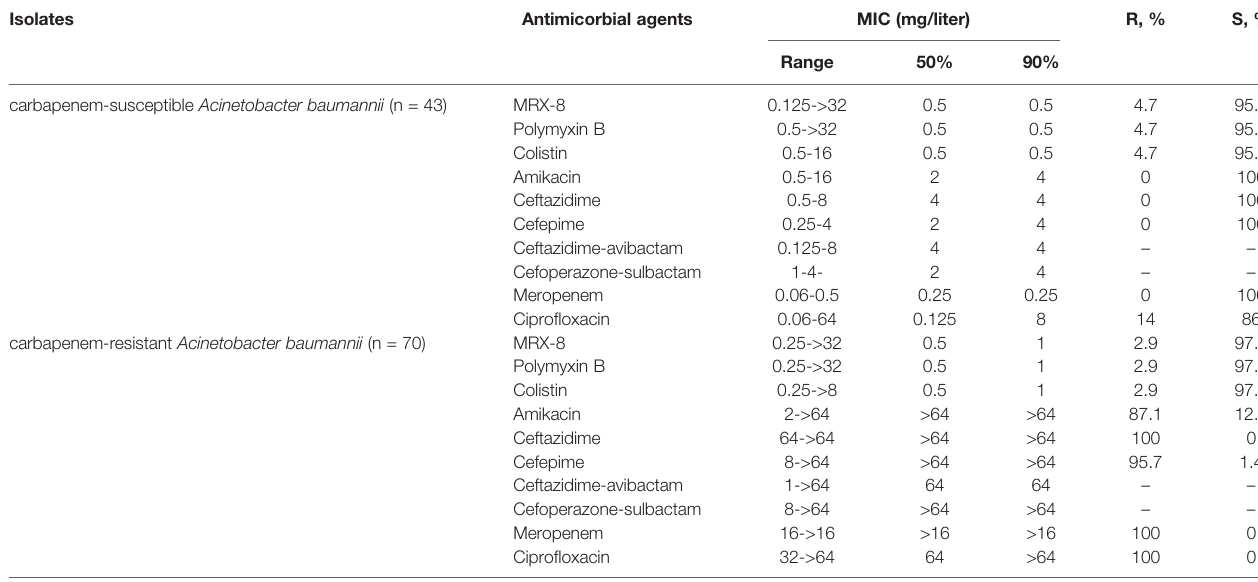
TABLE 5 | In vitro activity of MRX-8 and other comparator agents against 113 of Acinetobacter baumannii (mg/L).